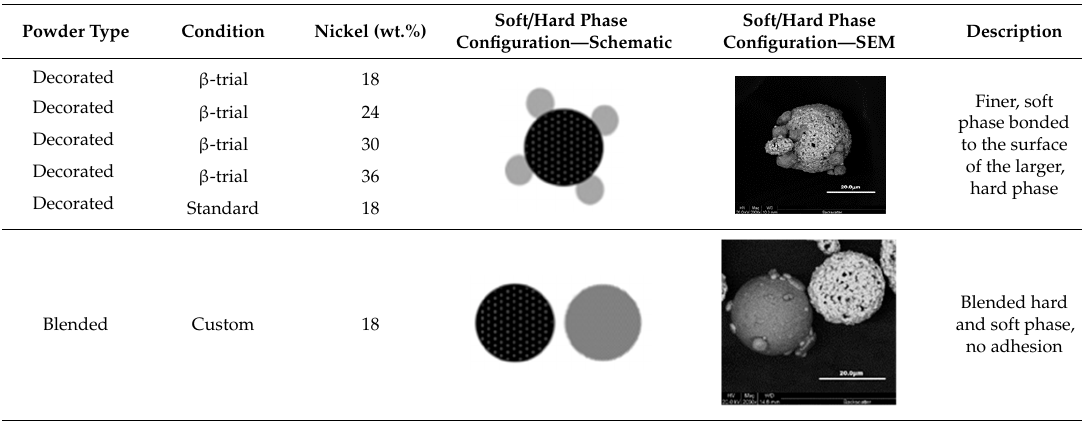
Table 1. Composition and configuration of evaluated powders.